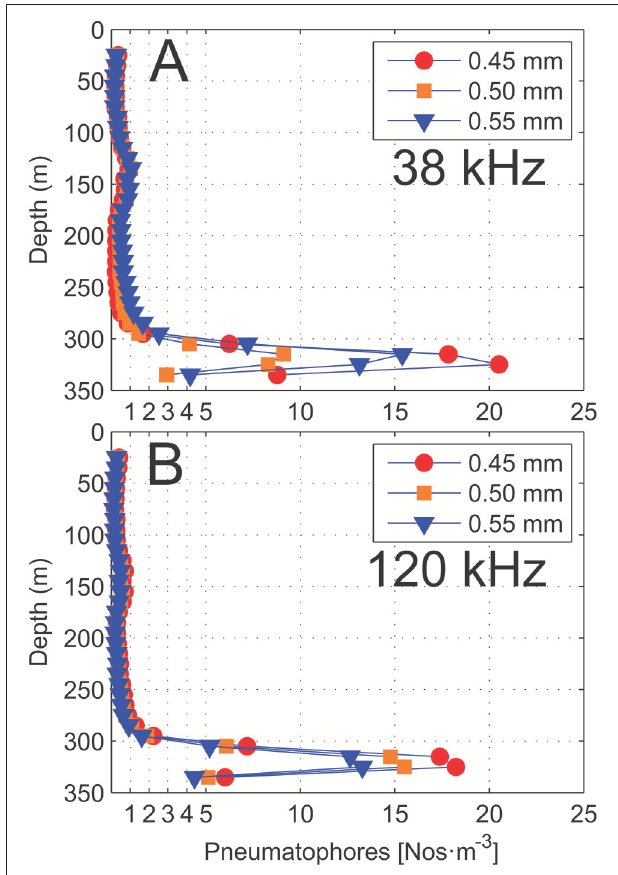
FIGURE 14 | Number of Nanomia pneumatophores [Nos · m − 3 ] as determined based on the theoretical depth dependent target strengths (TS) using the hybrid damped model for three different sizes of siphonophore gas-inclusions with bubble radius 0.45, 0.50, and 0.55mm. Computations based on (A) 38kHz and (B)